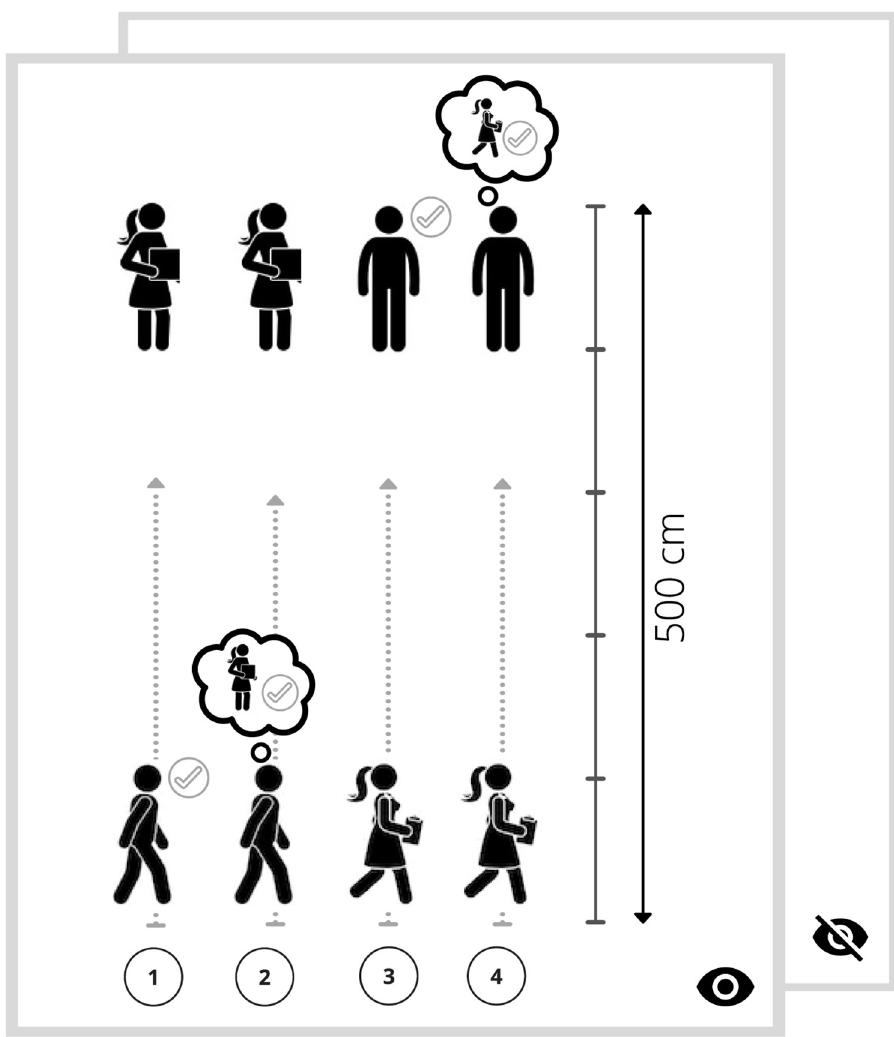
Fig 1. Experimental setting. The modified version of the stop distance paradigm. First, (1) participants were approaching actively and were asked to stop where it still felt comfortable for them. Next (2) participants were approaching actively and were asked to stop where they thought it was still comfortable for the experimenter. Then (3) participants stood passively and were asked to stop the experimenter where it was still comfortable for them; finally (4) participants stood passively and were asked to stop the experimenter where they thought it was still comfortable for the experimenter. Participants repeated this procedure twice with and without eye contact; the order of the latter two conditions was randomised across